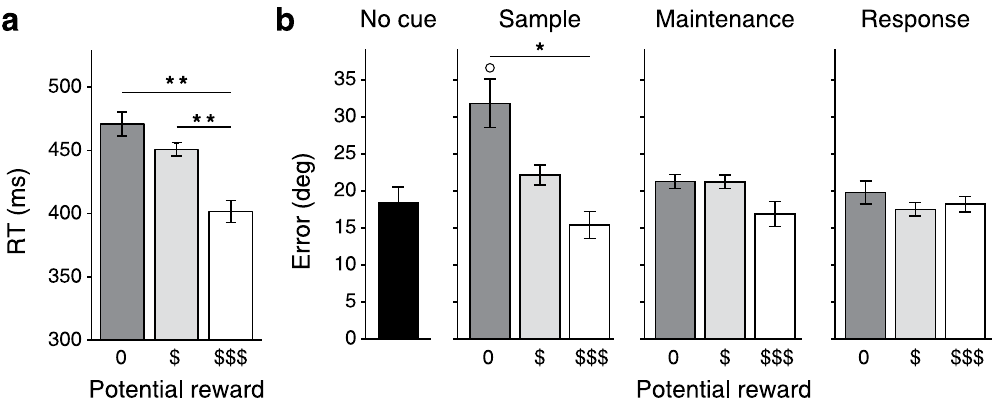
Figure 2. Results of Experiment 1. ( a ) Results of the color-reward association task of Experiment 1 averaged over all participants ( n = 10). Correct color reports were generally faster for colors associated with higher rewards. ( b ) Results of the working memory task of Experiment 1 ( n = 10). The error between the reported and the remembered orientation was smaller for stimuli surrounded by a colored ring predicting higher rewards, but only during the sample phase of the task. Error bars represent within-subjects s.e.m.’s 88 . Asterisks indicate significance levels for pairwise comparisons between reward cues ( * p < 0.05; ** p < 0.01). The open circle indicates a significant difference from the no cue condition ( p <